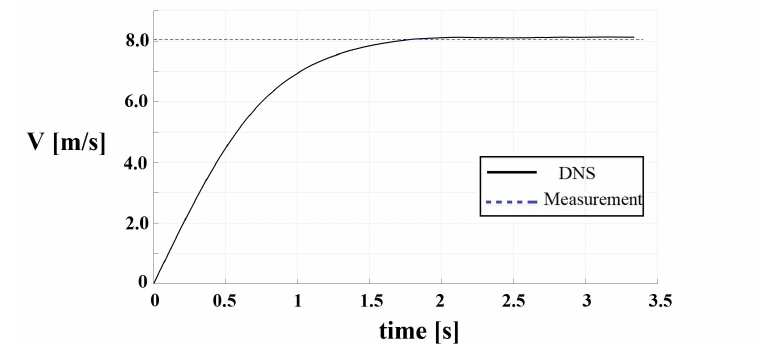
Figure 4. The black curve illustrates the time evolution of the simulated fall velocity of a 3 mm water drop in stagnant air. The dashed line displays the corresponding terminal velocity according to Gunn and Kinzer [11] ( v t = 8.06